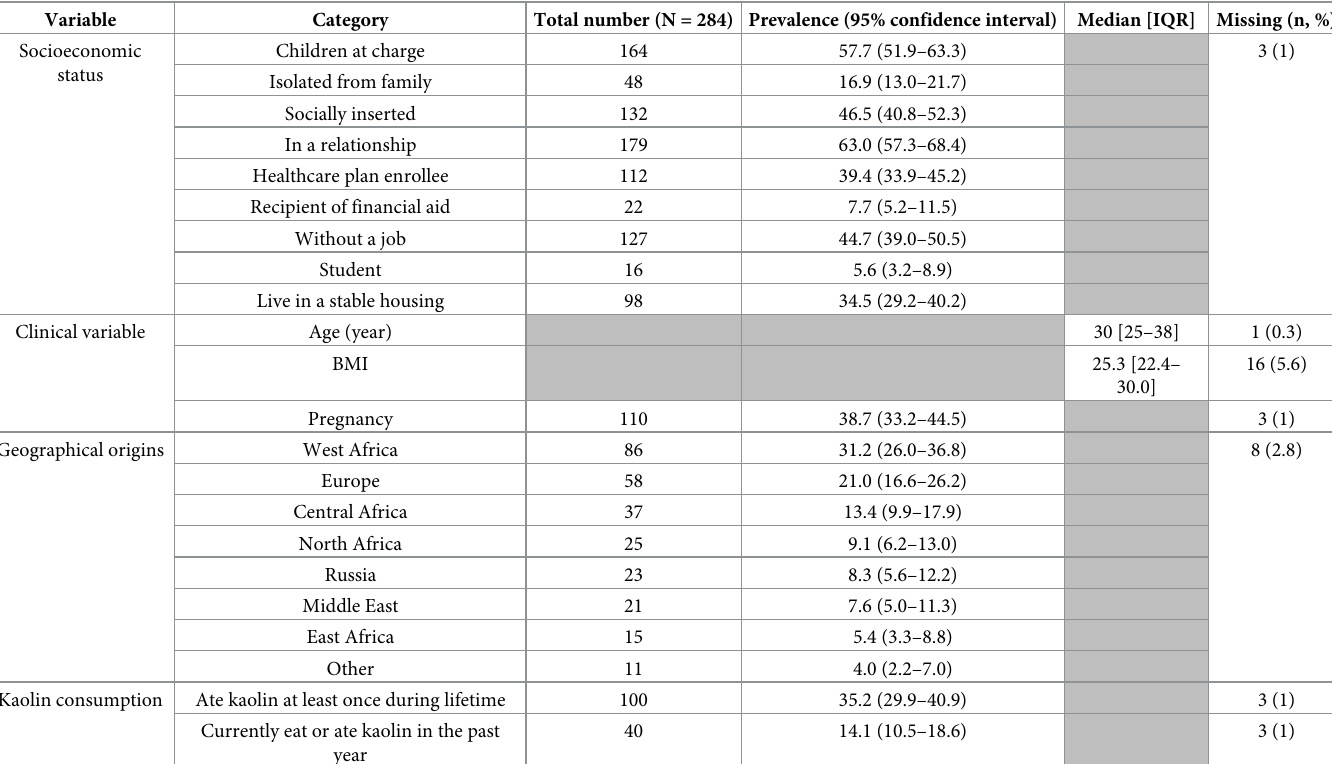
Table 2. Characteristics of the study